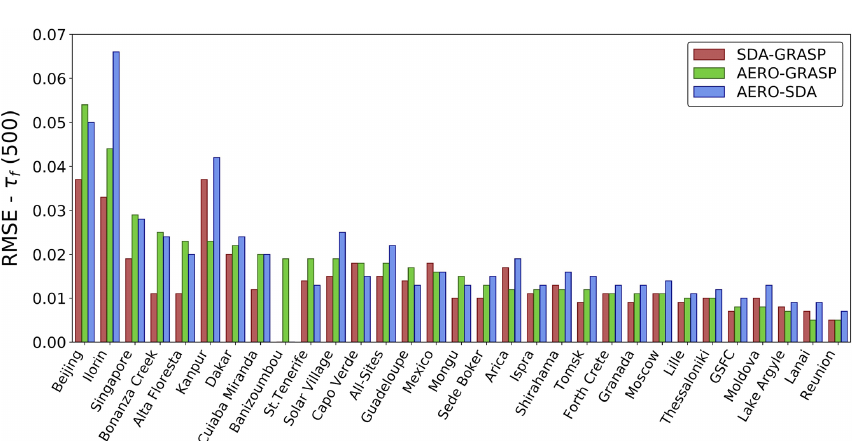
Figure 2. RMSE between τ f ( 500 ) retrieved by the SDA and GRASP-AOD (red bars), AERONET aerosol retrieval algorithm and GRASP- AOD (green bars) and AERONET aerosol retrieval algorithm and SDA (blue bars) (values can be found in Table 4) for all sites considered in the analysis (Table 1) from 1997–2016. The sites have been ordered according to the RMSE values between the AERONET aerosol retrieval algorithm and GRASP-AOD (green